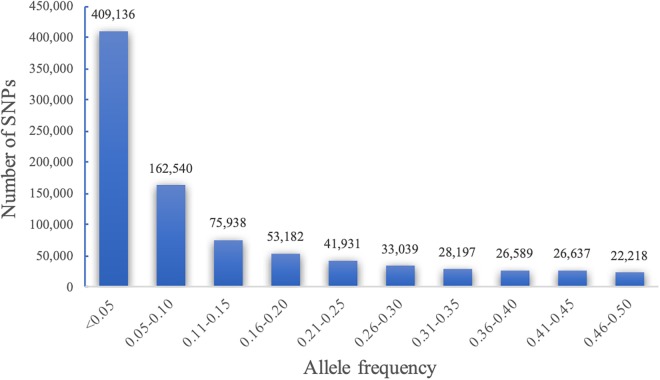
Minor allele frequency (MAF) and number of SNPs based on 1425 unique sorghum accessions from Ethiopia.